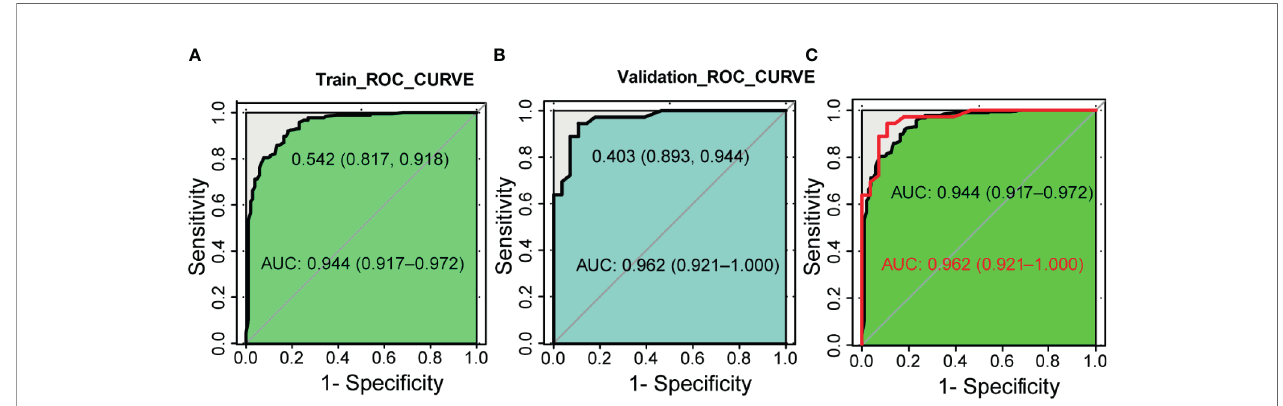
FIGURE 4 | The discrimination test of nomogram model (ROC analysis). (A) The area under the AUC of the training set is 0.944(95%CI 0.917~0.972, P < 0.001), the best diagnostic threshold is 0.542. (B) The AUC of the validation set is 0.962 (95% CI 0.921~1.000, P < 0.001), the best diagnostic cut-off value is 0.403. (C) Combination of panels (A, B) . AUC, the area under the receiver operating characteristic curve; ROC, the receiver operating characteristic.